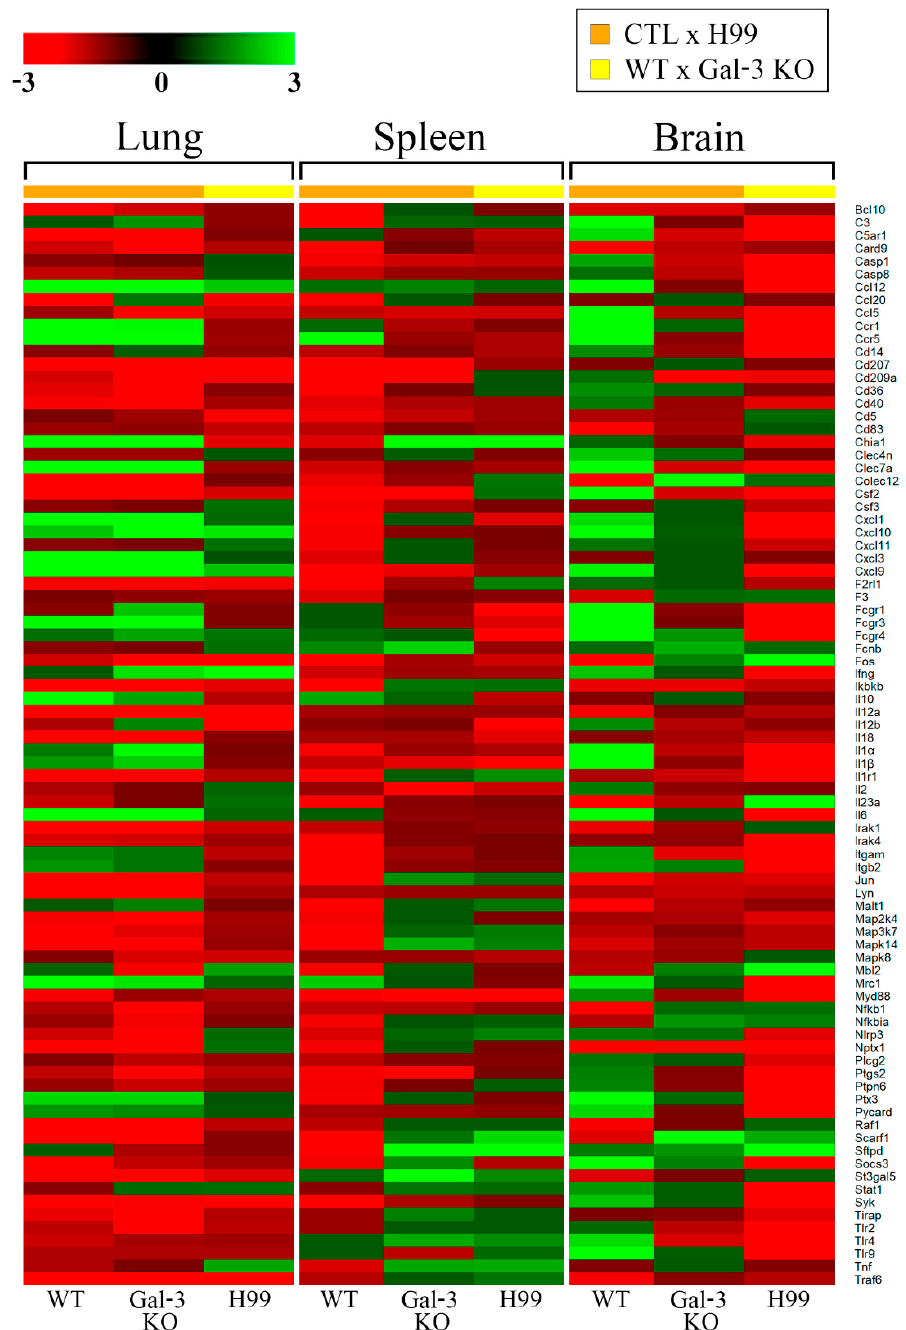
Figure 2. Heat map of gene expression of innate antifungal immunity in the lungs, spleen, and brain of the WT and Gal-3 KO mice during cryptococcosis. The analyses were based on the following comparisons: C. neoformans infection compared to the control group, in both the WT and Gal-3 KO animals (represented by orange bars), and WT compared to Gal-3 KO animals infected situation (represented by yellow bars). The analyses were performed in the lungs, spleens, and brains after seven days of C. neoformans infection. All control animals received phosphate-buffered saline (PBS) intratracheally. The scale represents the fold change, with a threshold equal to three (green: upregulated, red; downregulated, black: medium